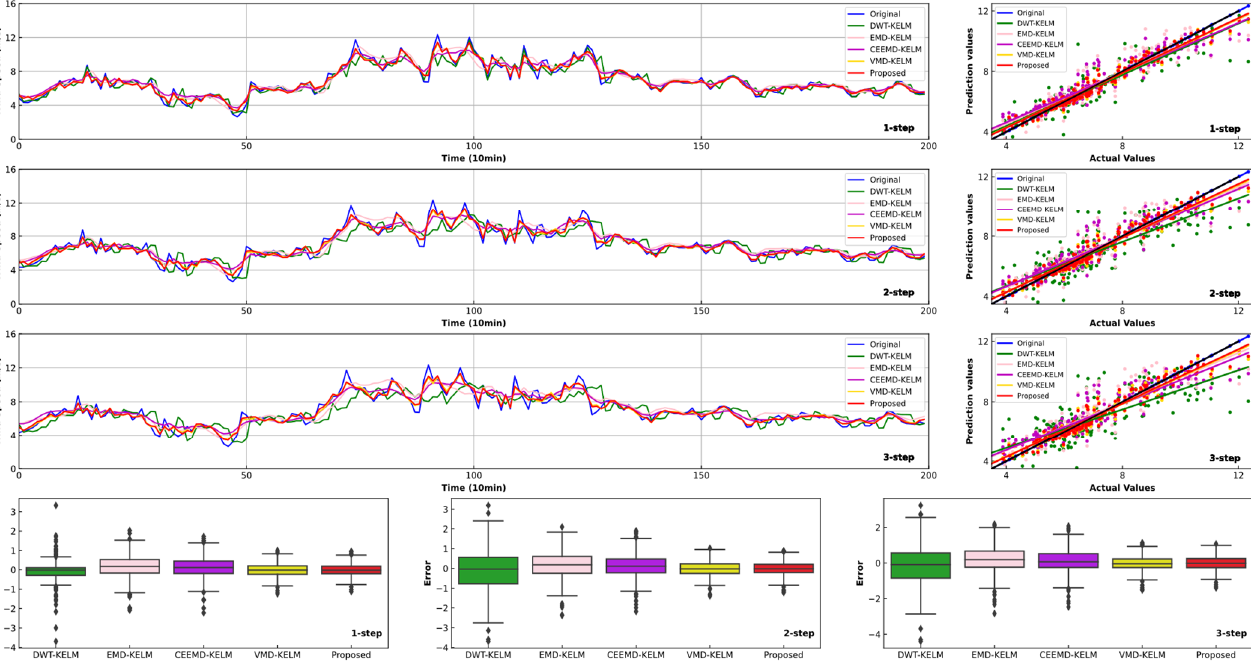
Figure 8. Forecasting performance of decomposed models in one, two and three-step ahead forecasting for the winter dataset. Table 4. Comparison of forecasting performances of the combined model and other models using different data prepro- cessing methods. DWT: discrete wavelet transform; EMD: empirical mode decomposition; CEEMD: complementary en- semble empirical mode decomposition; VMD: variational mode decomposition.